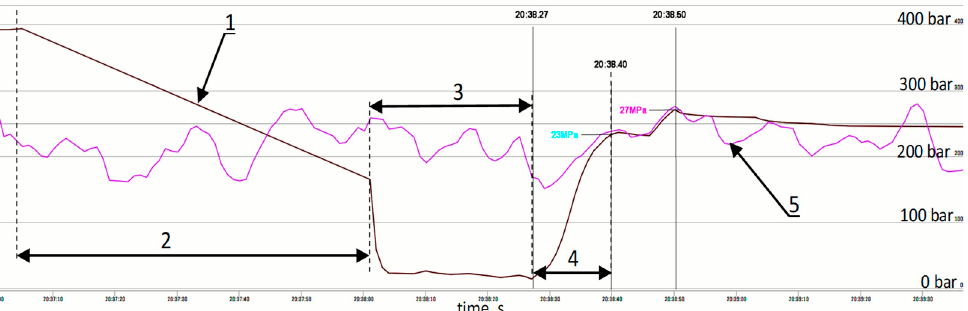
Figure 7. The course of the pressure value in the legs: 1, powered support no. 43; 2, leg withdrawal time 56 s; 3, adjustment time 26 s; 4, expansion time 23 s; 5, supply pressure.